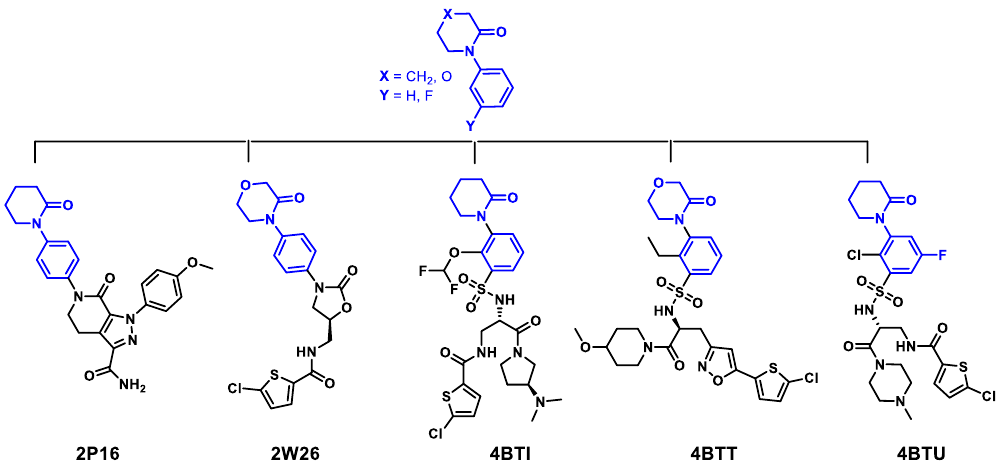
Figure 5. Virtual screening of interest fragment in FXa PDB crystallography data base.